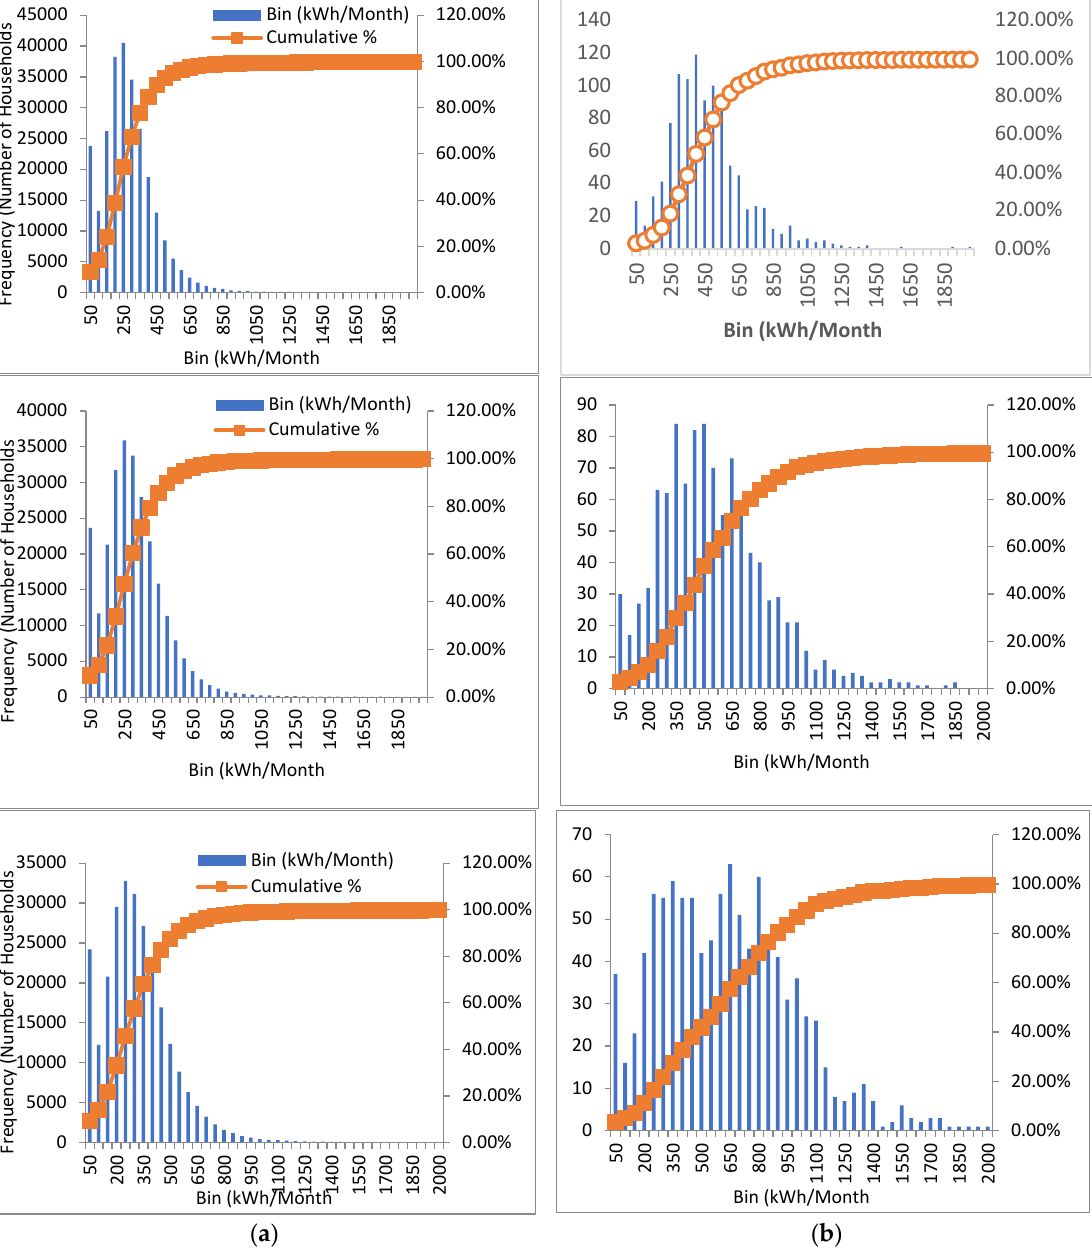
Figure 11. Energy consumption October, November and December: ( a ) Ordinary households; and ( b ) Subsidized households.